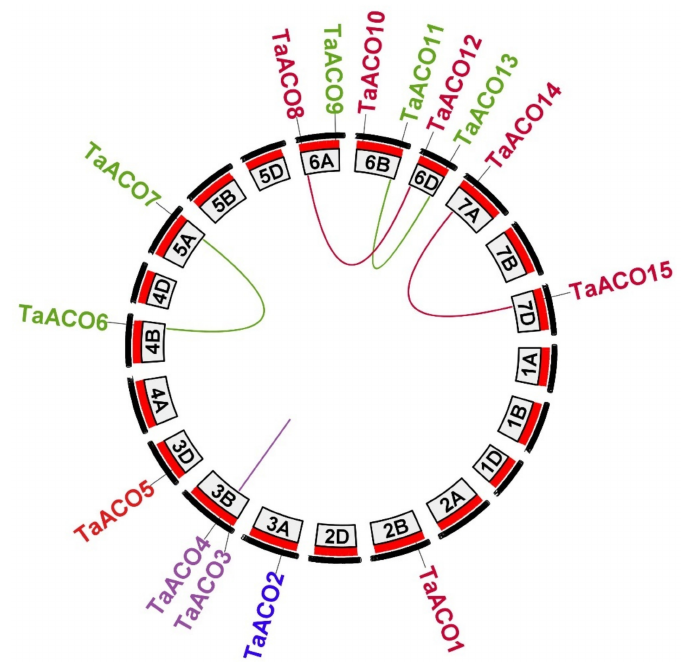
Figure 3. Chromosomal location and duplicated ACO genes in T. aestivum . Duplicated ACO genes are linked with distinct color lines and the figure was produced via TB